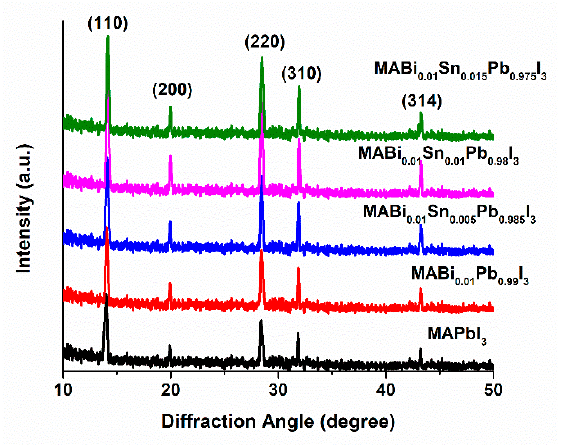
Figure 1. XRD spectra of pure and Bi–Sn co-doped MAPbI 3 . Grain Size (D) and Dislocation Line Density ( δ ) Grain size (D) describes the diameter of each grain sediment. By contrast, dislocation line density ( δ ) describes the defects or irregularities of the crystalline structure. Where dislocation line density is used to calculate the number of flaws in a sample, a lower δ value means that the film is of higher quality